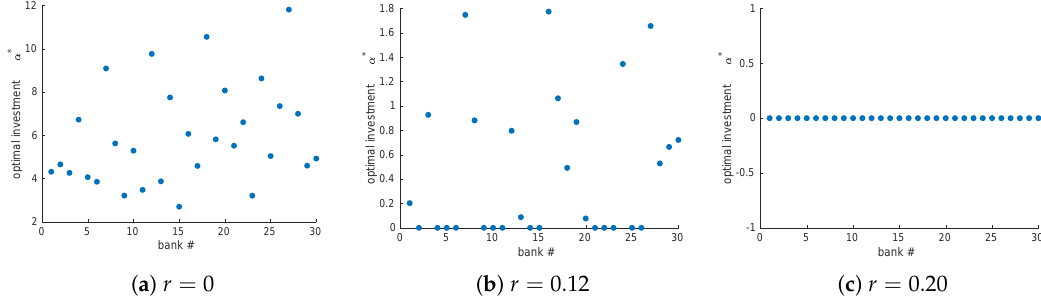
Figure 1. We use the following parameters for the simulations: N = 30 bank, time horizon T = 1, no correlation ρ 0 = 0, no interbank flows c i , j = 0, 1000 time steps and µ i , σ i , i = 1, . . . , N i.i.d. uniform [ 0.1,0.2 ] .